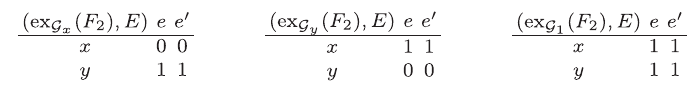
Soft sets associated with the extreme elements for ð F 2 ; E Þ : see Table